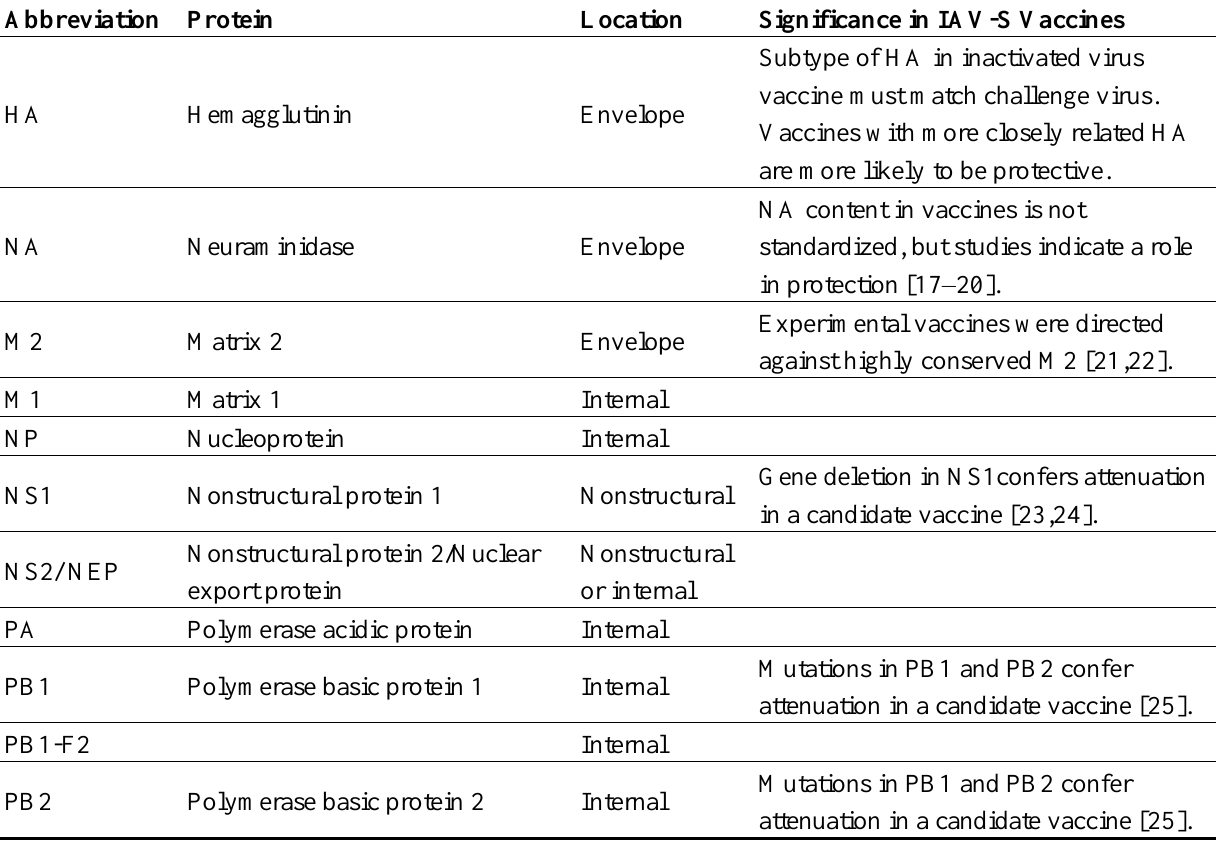
Table 1. Influenza virus